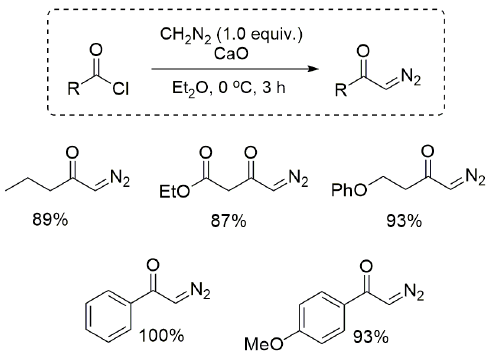
Figure 11 - Improved Arndt-Eistert synthesis of α-diazoketones by Pace and co-workers.